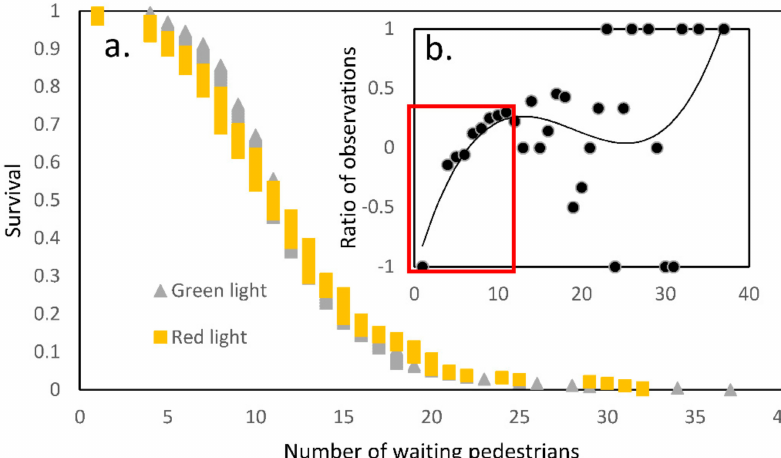
Figure 5. ( a ) Survival analysis of the number of waiting pedestrians at the time of crossing at the green light (grey) and the red light (yellow); ( b ) Ratio of observations for crossings according to the number of waiting pedestrians. -1 indicates that all crossings were made at the red light. 1 indicates that all crossings were made at the green light. 0 means that half of the observations were made at the green light (and, of course, half at the red light). A red square indicates data that can only be significantly explained ( p <